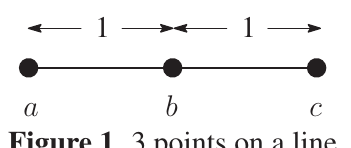
Figure 1 . 3 points on a line Figure 2 . Triangle